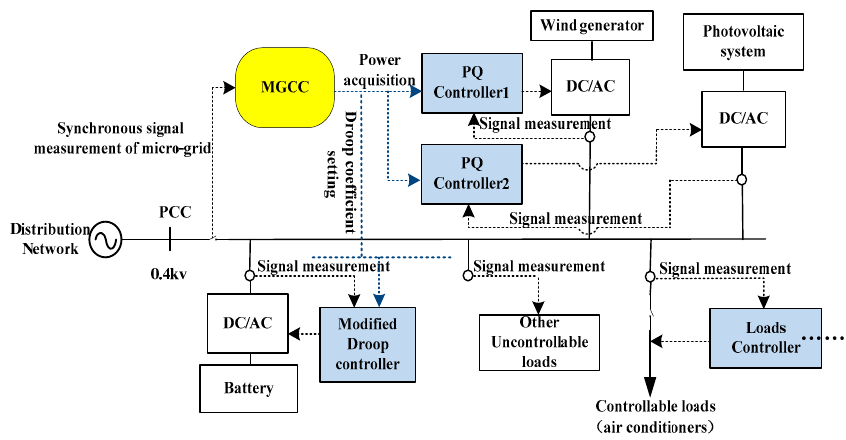
Figure 1. The hierarchical control structure of an isolated micro-grid.